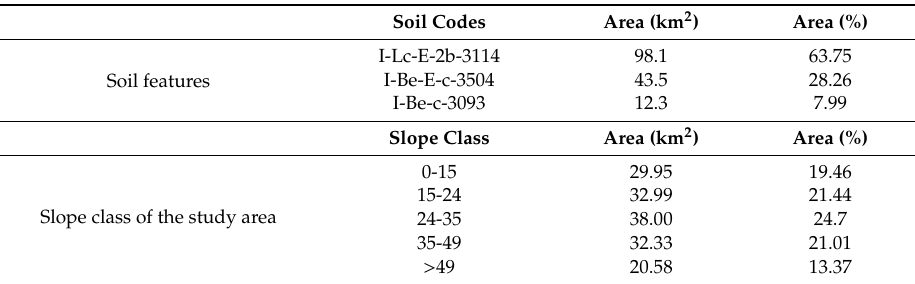
Table 2. Characteristics of soil type codes and slope class in the study area.